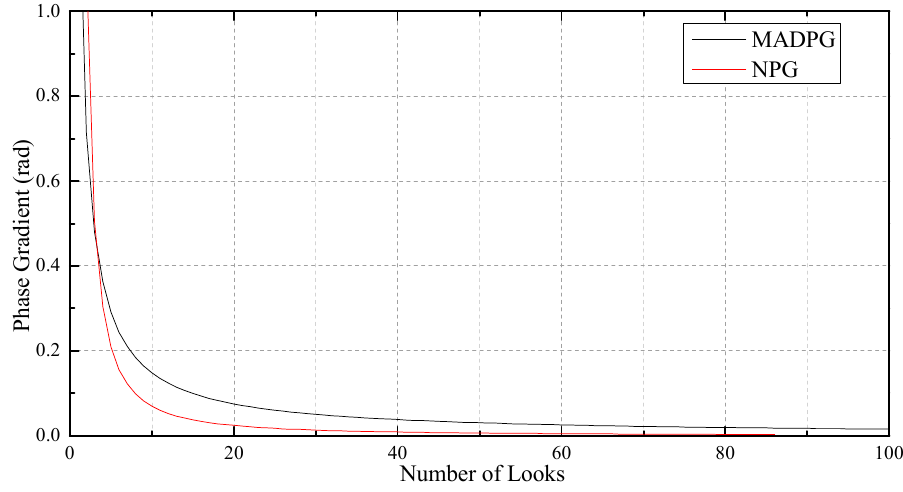
Figure 4. Relationship among the number of looks, the maximum detectable phase gradient, and the noise phase gradient.